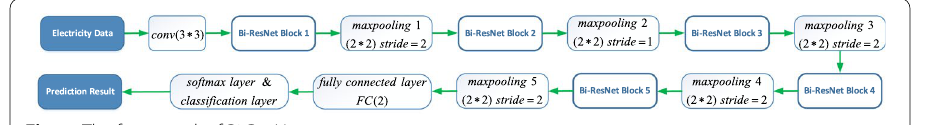
Fig. 4 The framework of